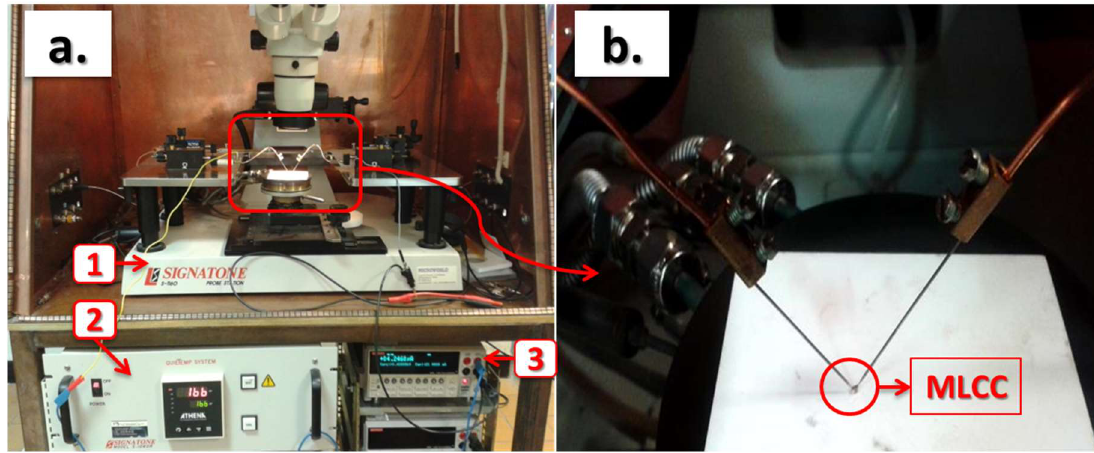
Figure 2. ( a ) Experimental set-up: (1) probe station, Signatone S-1160; (2) heating chuck, Signatone S-1060R; (3) sourcemeter unit, Keithley 2410. ( b ) Enlarged view of the MLCC under test.